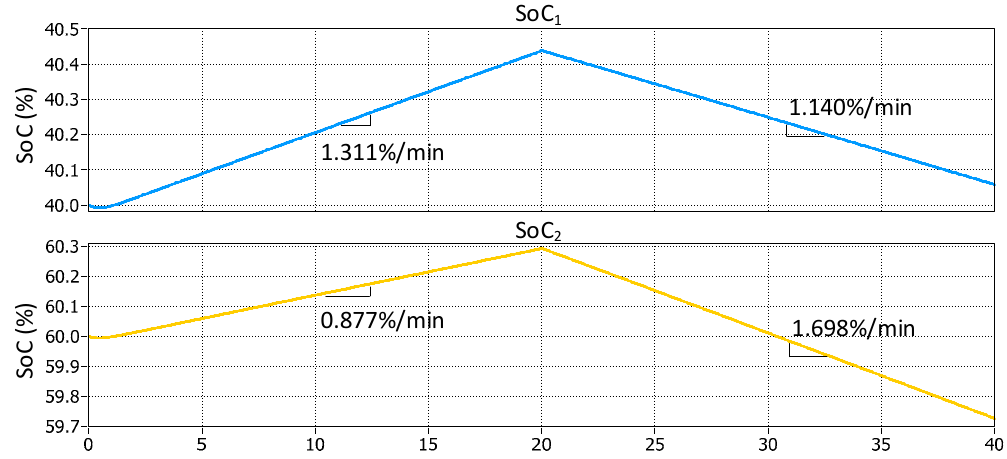
Figure 13. The rectifier, battery current, and battery voltage in hybrid mode.